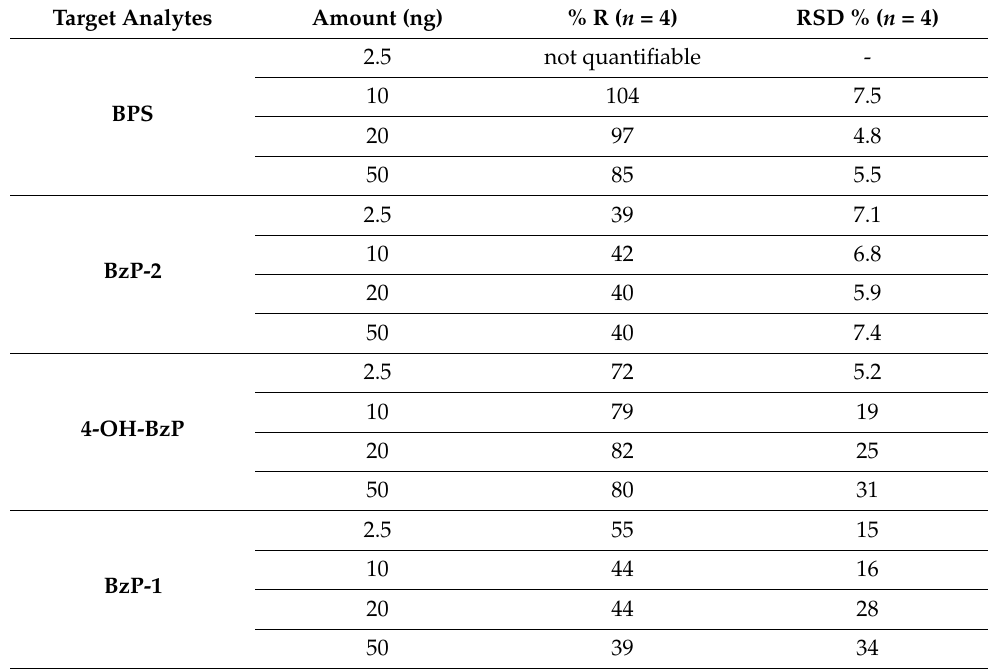
Table 1. Recoveries (%R) of the target analytes (fortified amounts: 2.5, 10, 20 and 50 ng; n = 4 replicates for each